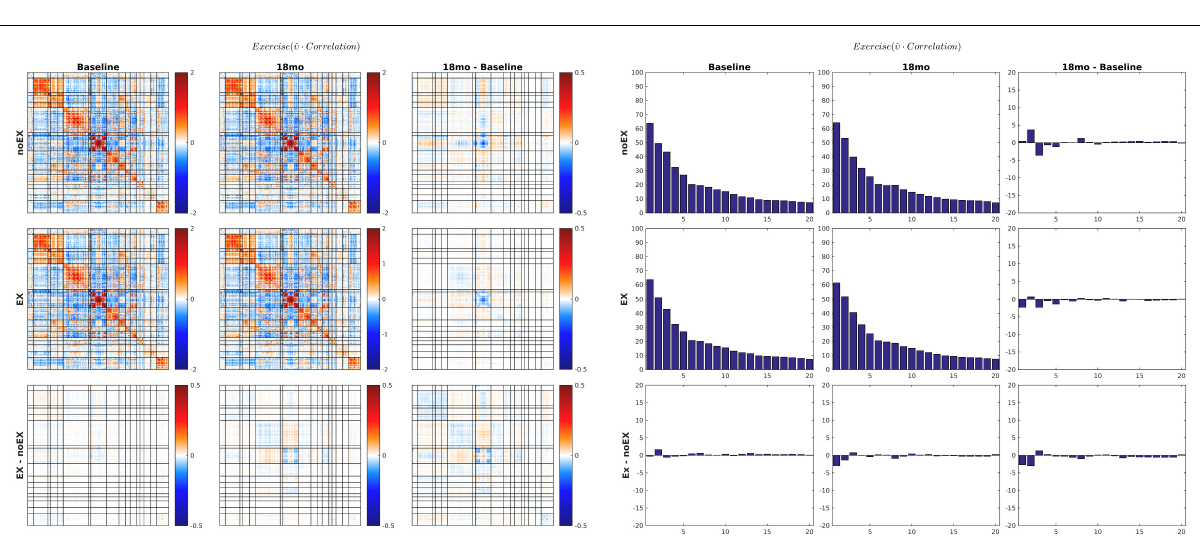
FIGURE 6 | 18-months vs. baseline effect of exercise on correlation FC. The format of this figure is identical to Figure 5 . As in Figure 6 , the information content of the matrix and bar plot displays is identical. Statistical testing of the lower right bar plot is illustrated in Figure 7B